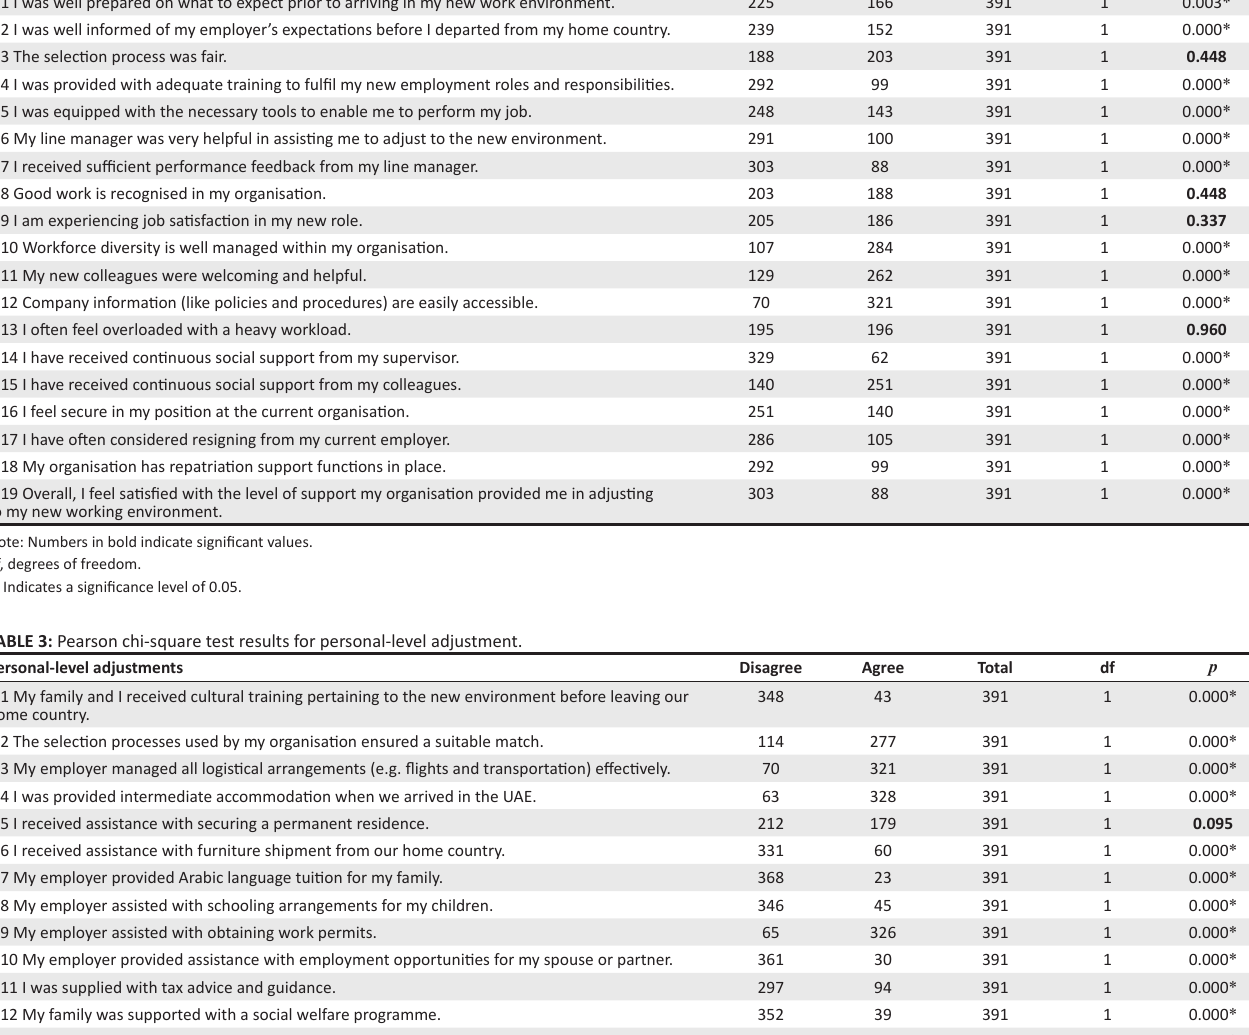
TABLE 2: Pearson chi-square test results for work-related adjustment. Work-related